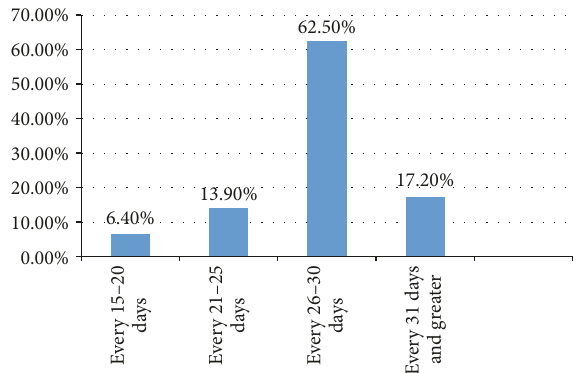
Figure 3: Length of menstruation cycle among female students of UOG, Gondar, 2016.